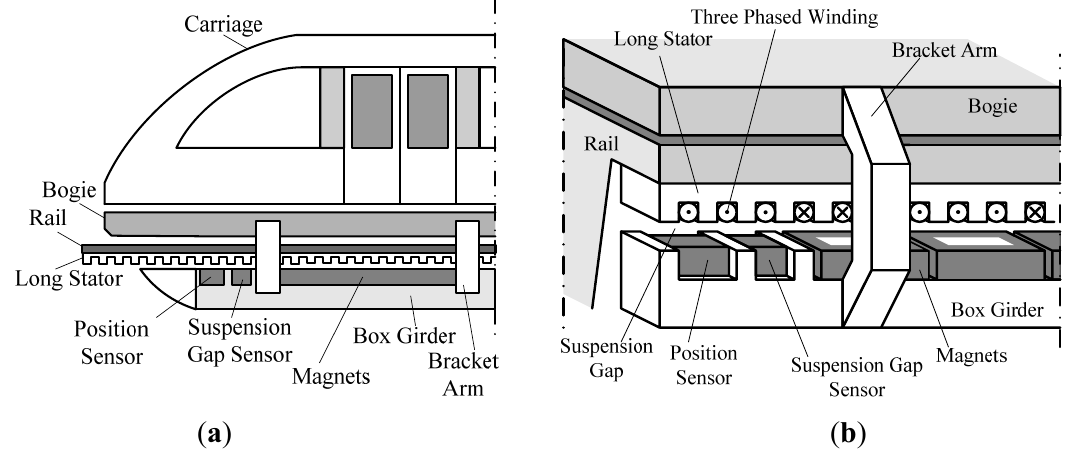
Figure 1. ( a ) Sketch map of high speed maglev train; ( b ) Arrangement of the long stator and the